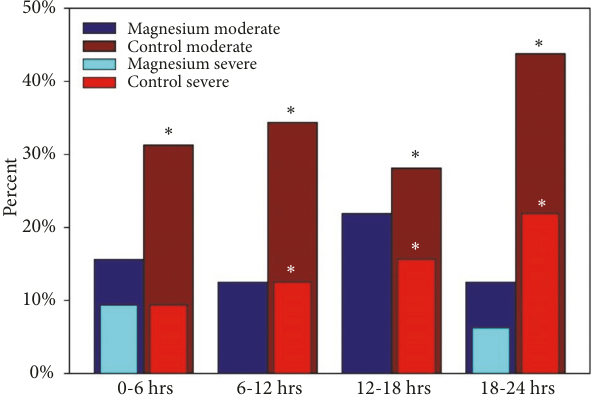
Figure 3: Proportions of patients registering moderate to severe pain in the magnesium and control